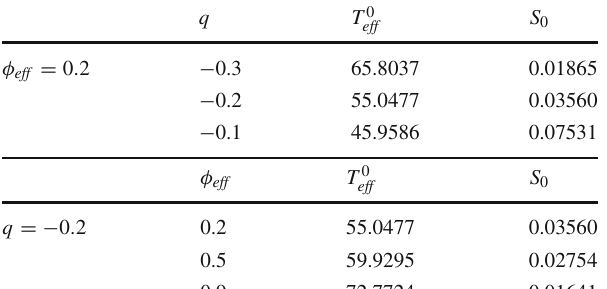
at the phase transition eff